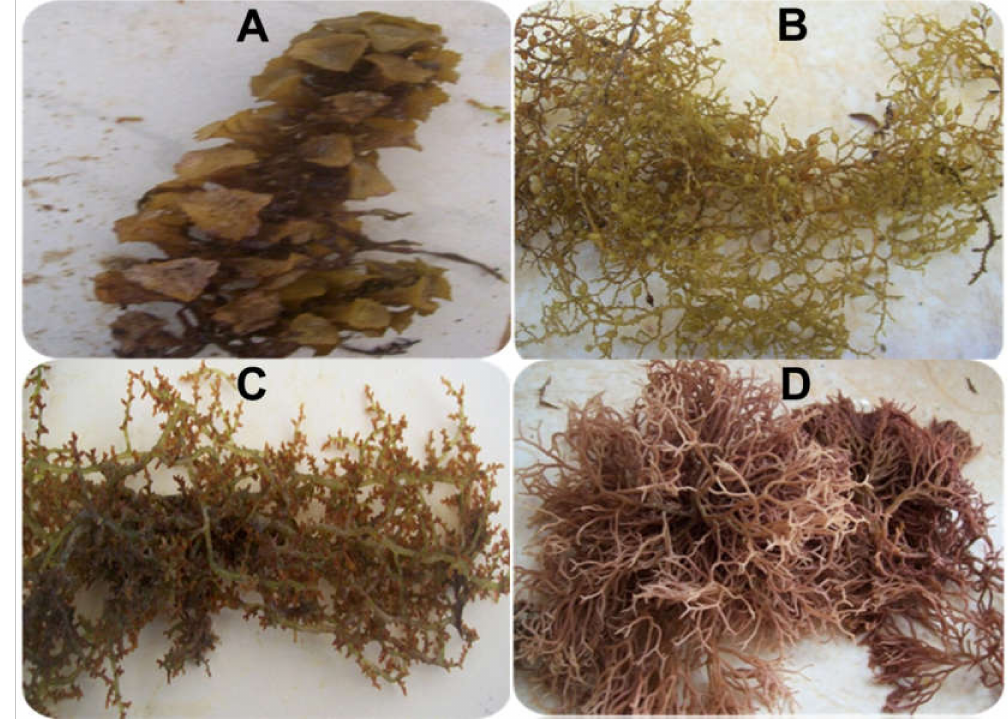
Figure 1. Photo of studied seaweeds: ( A , B ): the brown algae species: Turbinaria ornata and Polycladia indica , ( C , D ): the red algae species: Laurencia obtusa and Sarconema scinaioides ,